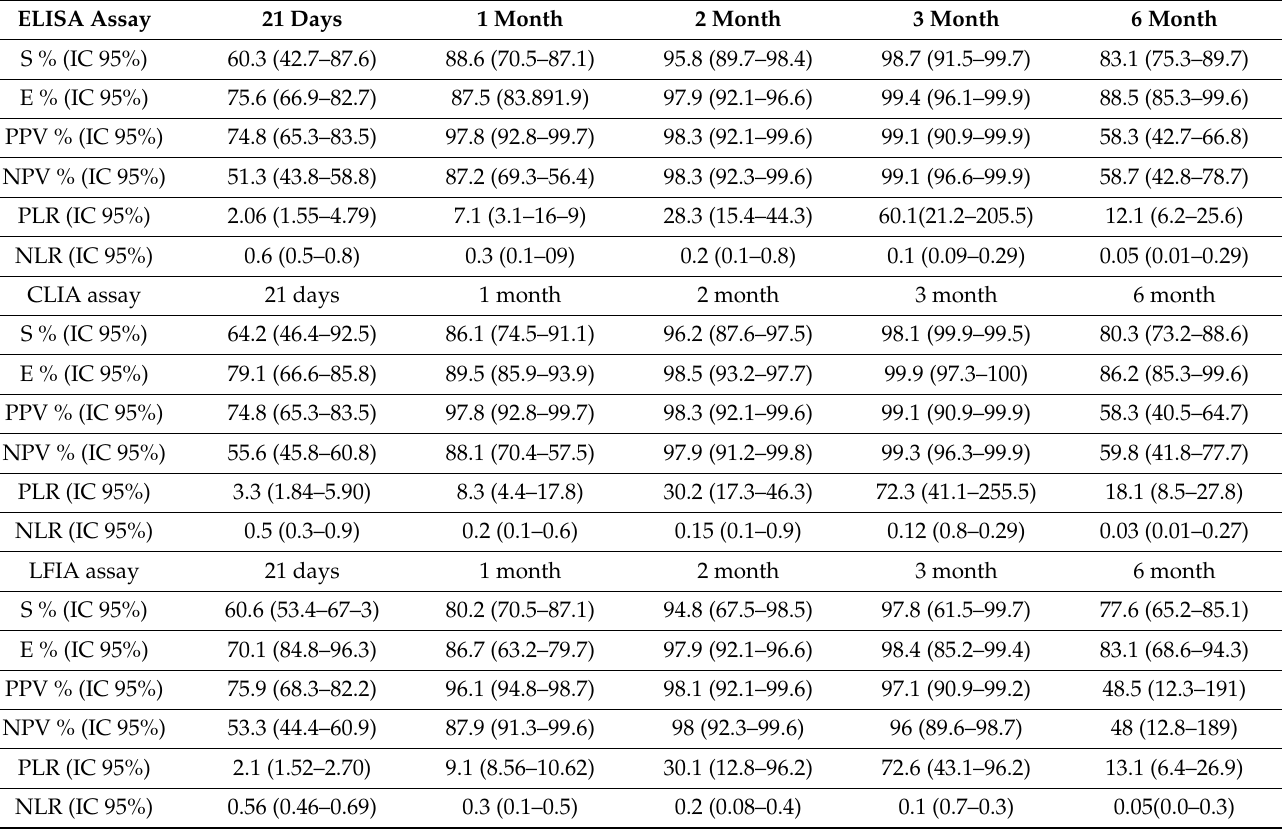
Table 1. Sensitivity, specificity, predictive value, and likelihood ratio of serologic IgG